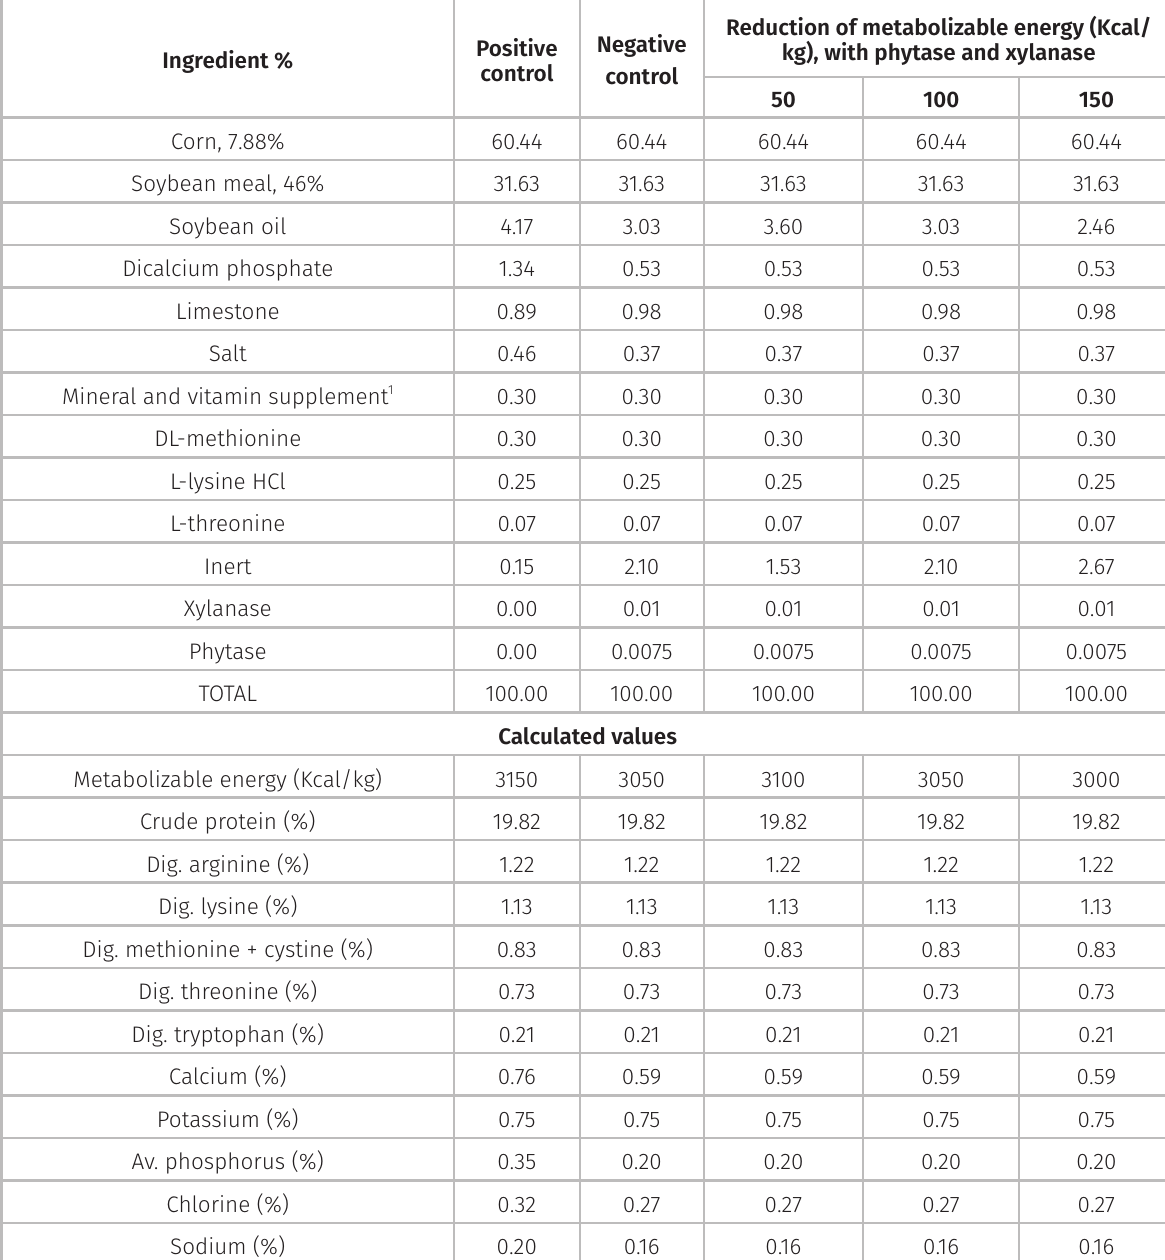
Table III. Centesimal and calculated compositions of experimental diets for broilers in the grower phase (22 to 33